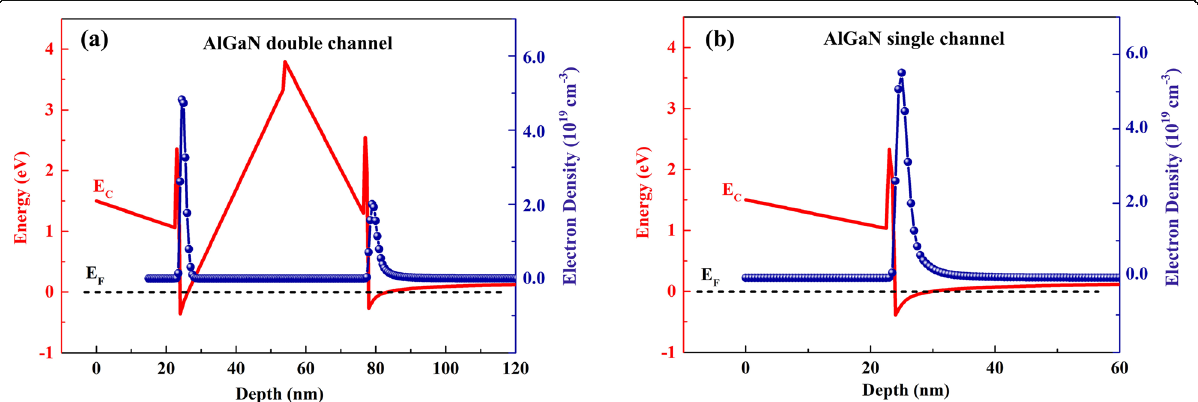
Fig. 2 Conduction band diagrams and electron density distributions of AlGaN double channel and single channel heterostructures